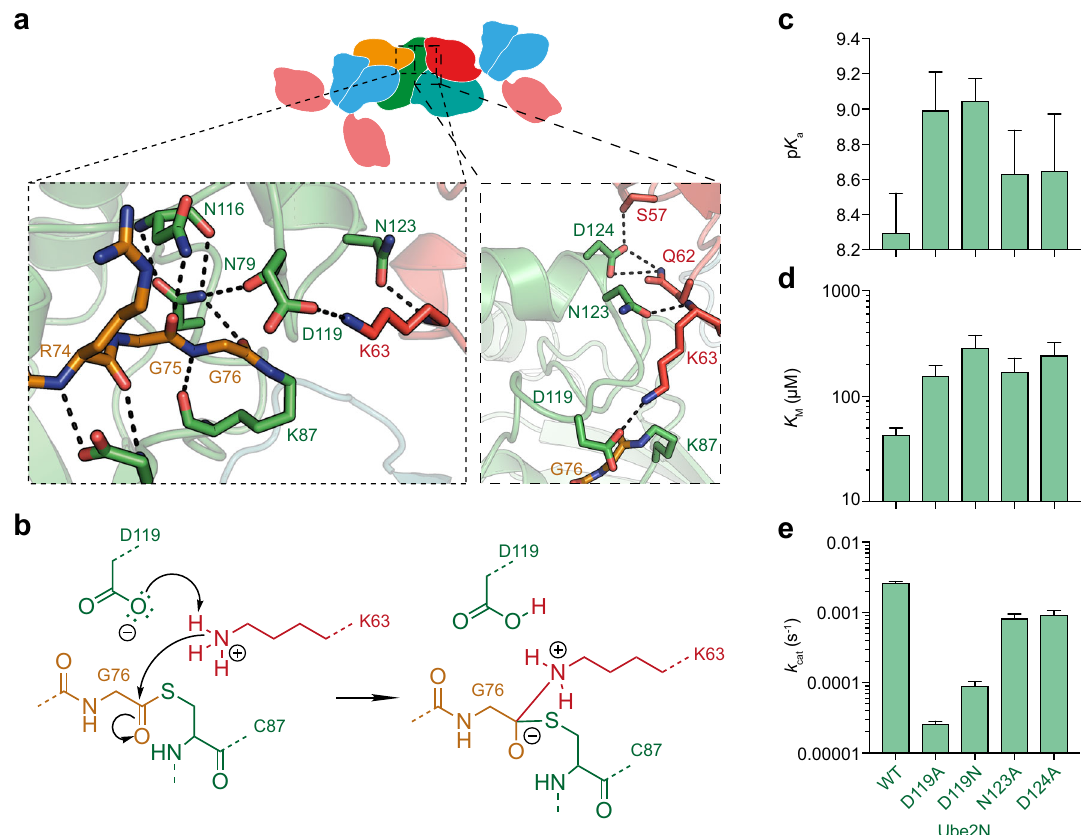
Fig. 2 Chemical mechanism of ubiquitination. a Magni fi ed regions of the active site of Ube2N~Ub/Ube2V2 (Ube2N in green, donor Ub in orange, acceptor Ub in red, and Ube2V2 in teal). Stereo-images are shown in Supplementary Fig. 1b. b Chemical scheme for the activation of the acceptor lysine. c Acid coef fi cients (p K a ), d K M , and e k cat of di-ubiquitin formation by Ube2N/V2 are presented as best fi t + standard error. Fits were performed using data of n = 3 technical replicates, and are shown in Supplementary Fig. 2 and Source data. Ub